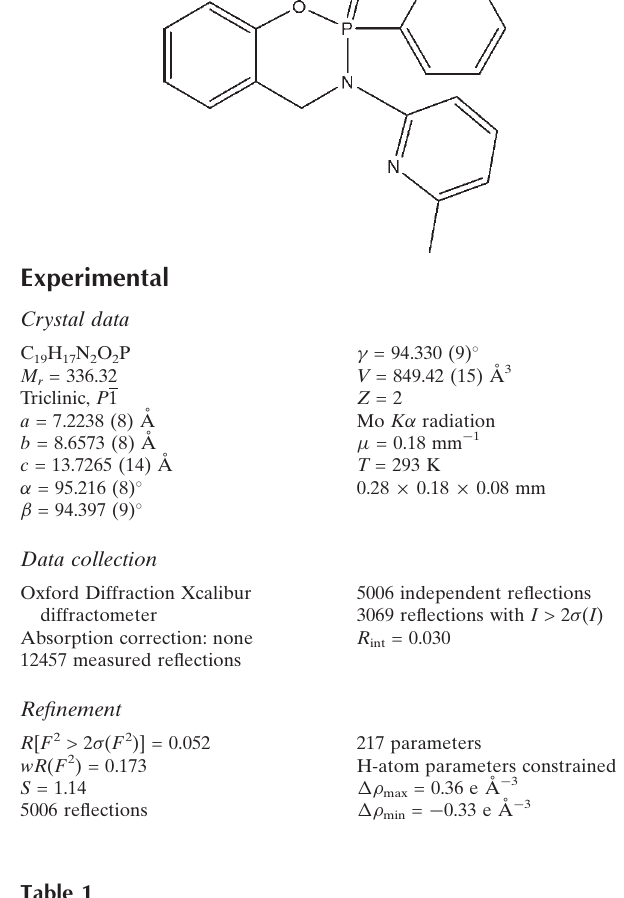
Hydrogen-bond geometry (A˚ , (cid:2)